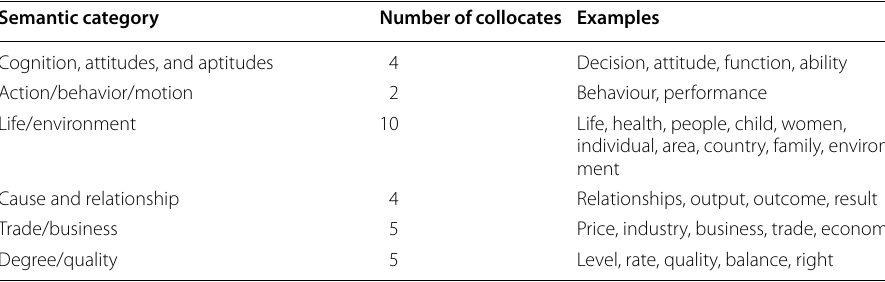
Table 11 Semantic categories of the object nominal collocates of affect Semantic category Number of collocates Examples Cognition, attitudes, and